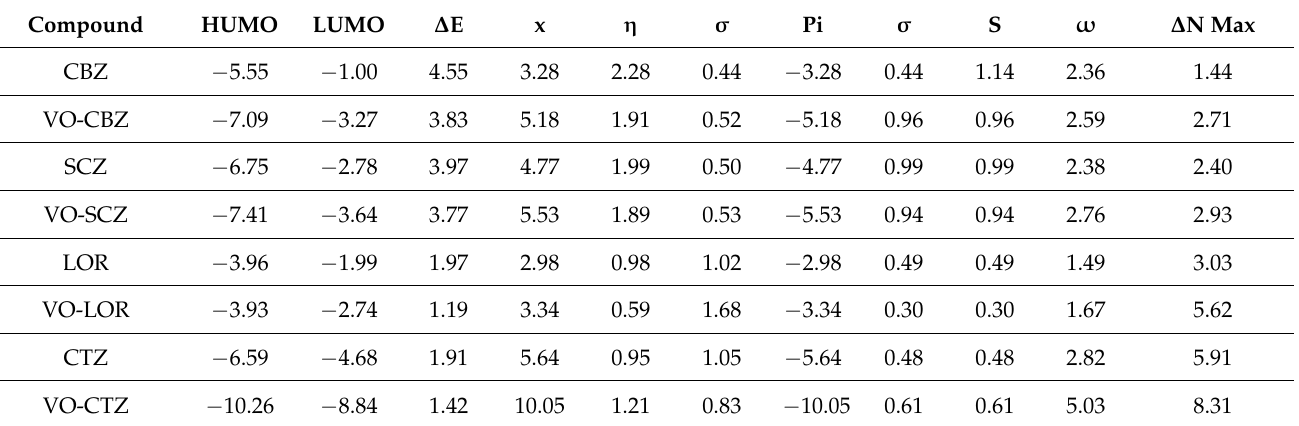
Table 7. E HOMO , E LUMO , Eg, and the ligand’s quantum parameters and complexes using B3LYP/LANL2DZ.